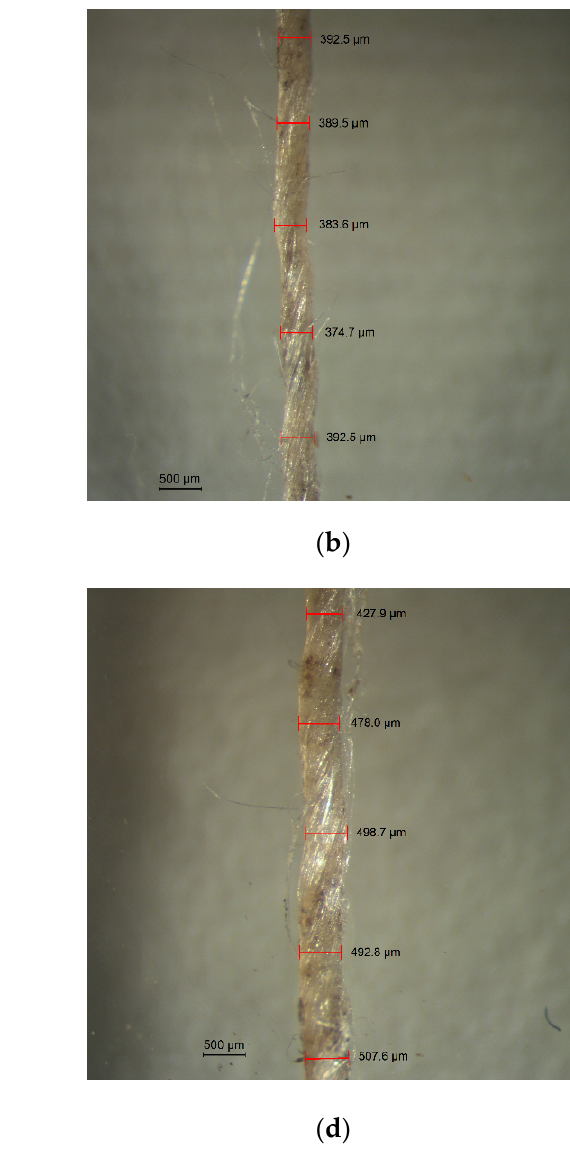
Figure 11. Optical micrographs of flax fibers for each treatment condition: ( a ) R, ( b ) C5, ( c ) C10 and ( d ) C20 fibers.